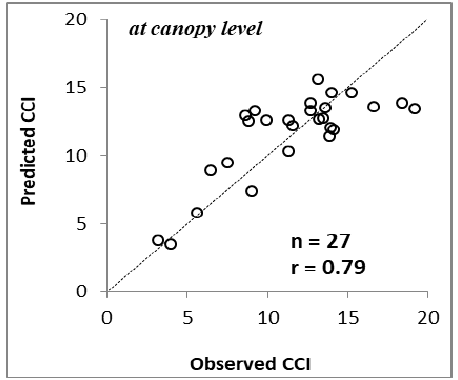
Figure-10 Predicted CCI vs Observed CCI